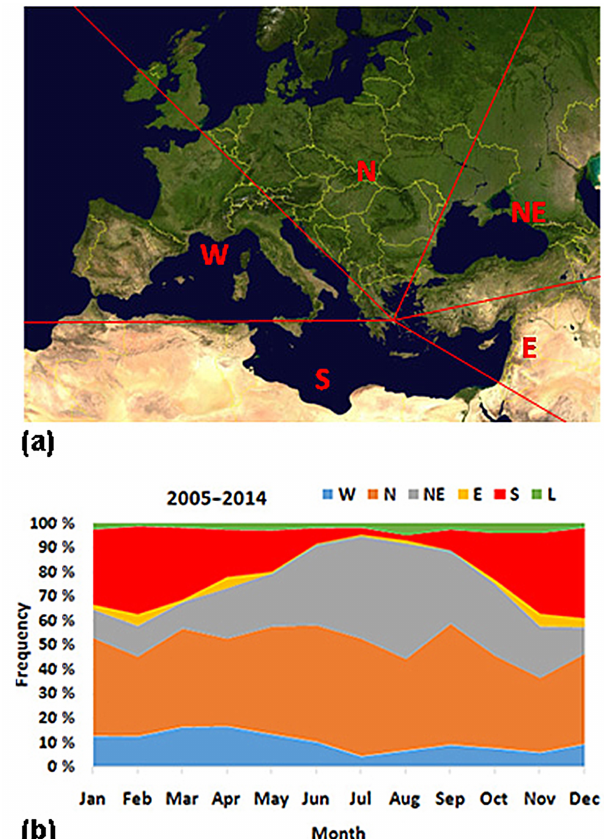
Figure 2. (a) Main sectors related to air mass origin in Athens. (b) Seasonal variability of the relative frequency of air mass ori- gin in Athens, following the sectors defined in (a) , averaged over the period 2005–2014. Category “L” refers to air masses of local